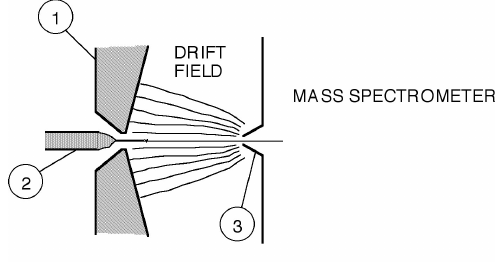
Figure 9 . Concept design, version #1.